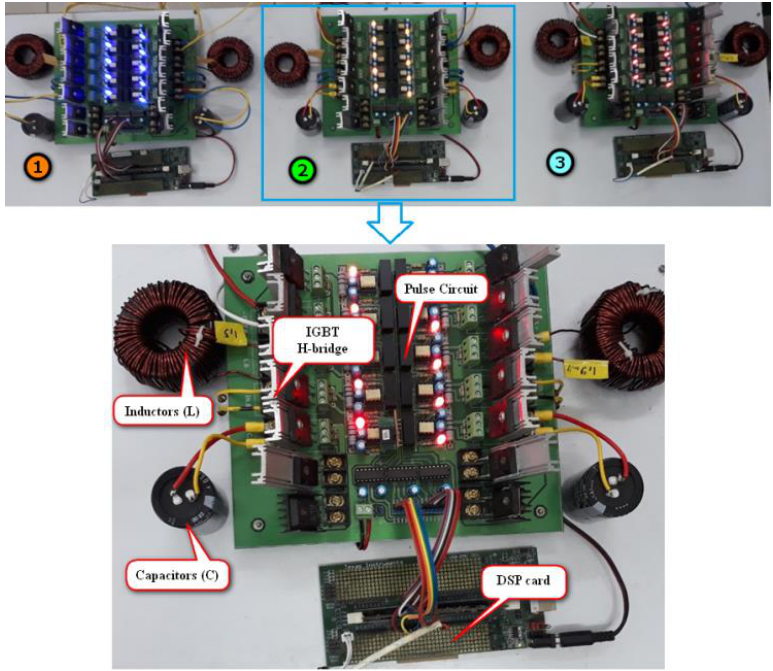
Figure 8. The prototype model with three-phase CHB-qSBI. Figure 9. The prototype model with three-phase